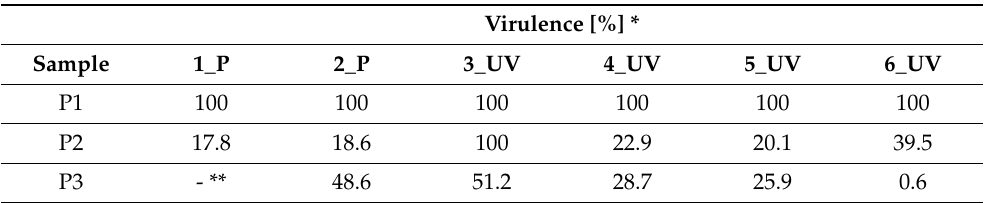
Table 2. Measured virulence at the different sampling times (P1 to P3). The phage concentration at the sampling time P1 is set as